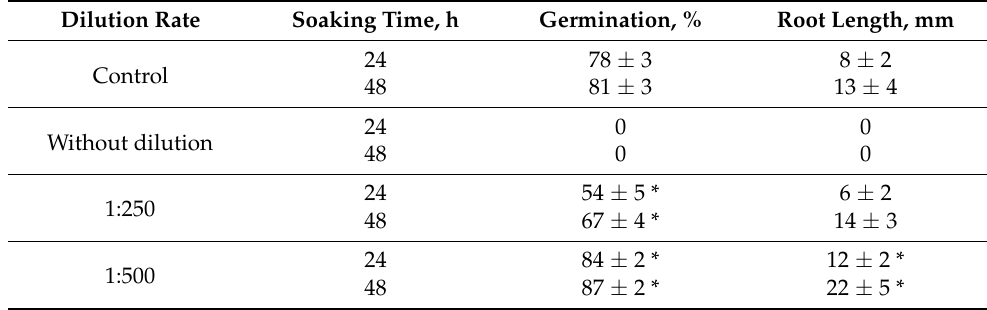
Table 5. The main parameters of sorghum seedlings after 120 h from the moment of soaking in activated water and its solutions for 24 and 48 h.